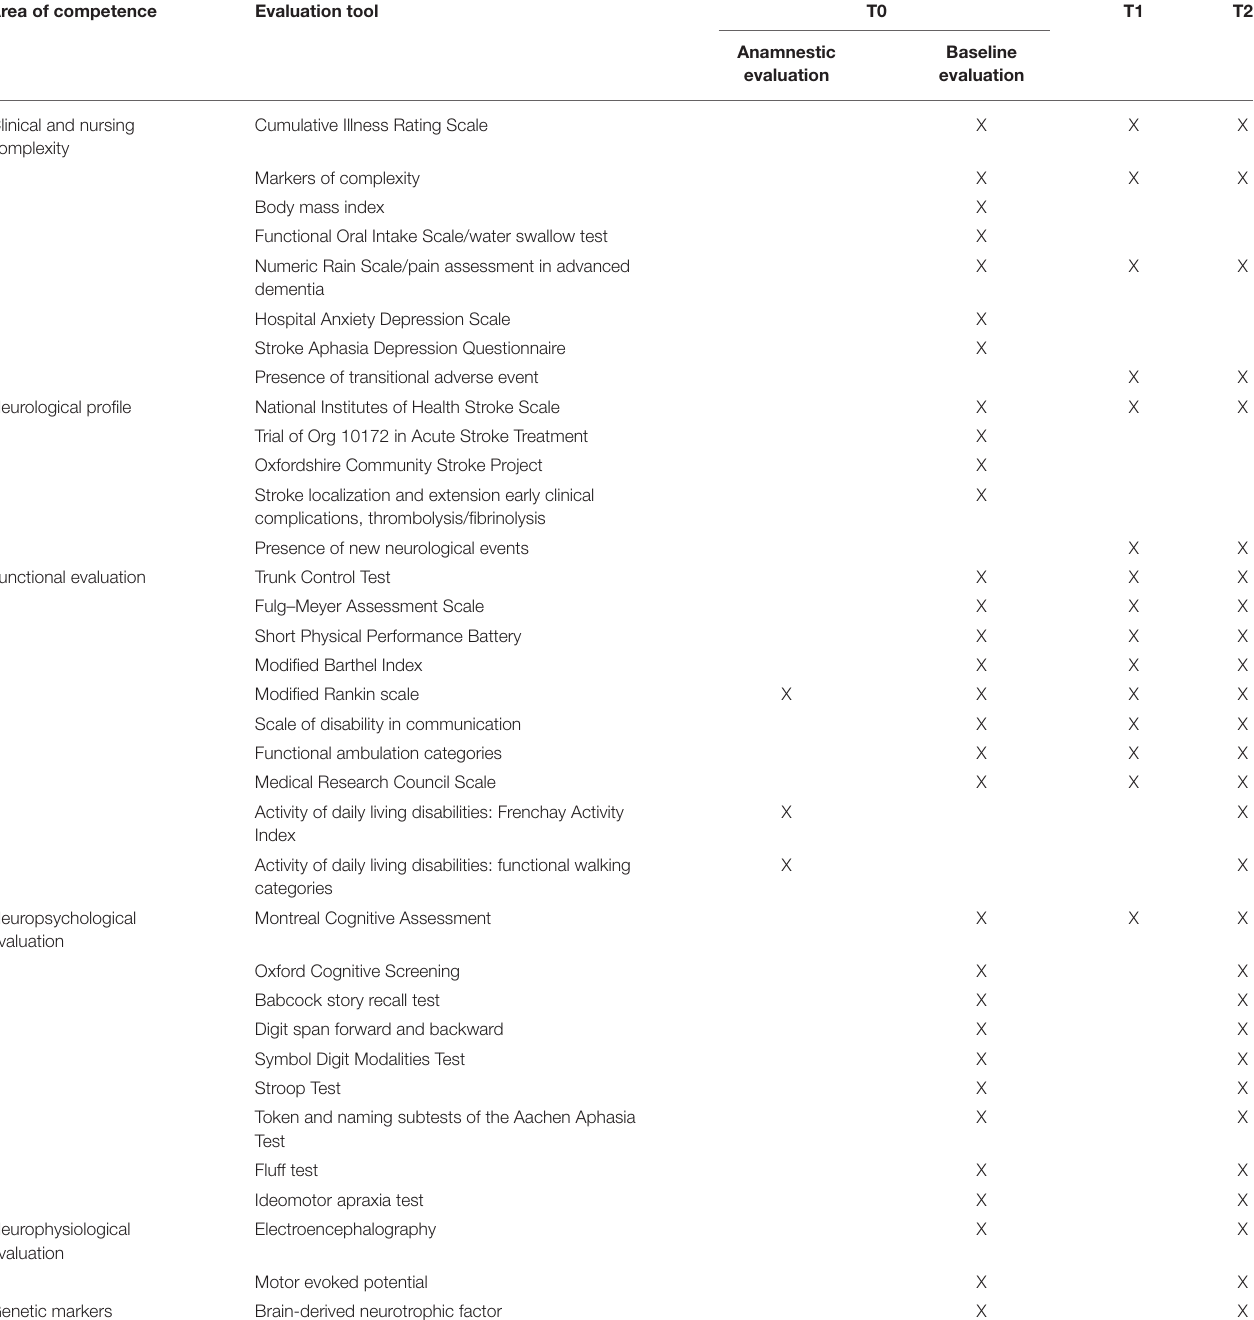
TABLE 1 | Administrated scales and evaluations. Area of